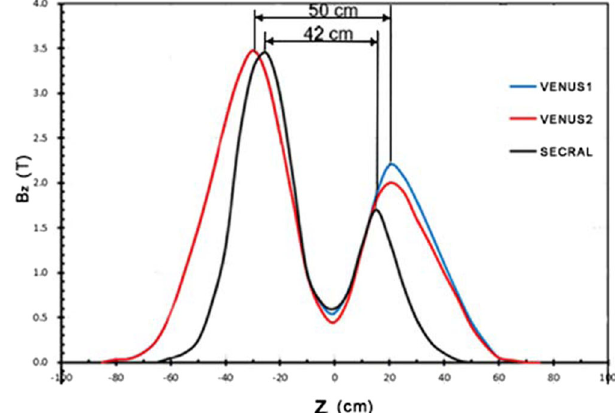
FIG. 21. Comparison of the axial magnetic field distribution between SECRAL and VENUS. (The blue line VENUS1 and the dark line SECRAL are the magnetic field distribution for optimizing high intensity 209 Bi 30 þ beam respectively. The red line VENUS2 is the new field distribution for VENUS after modifications.)